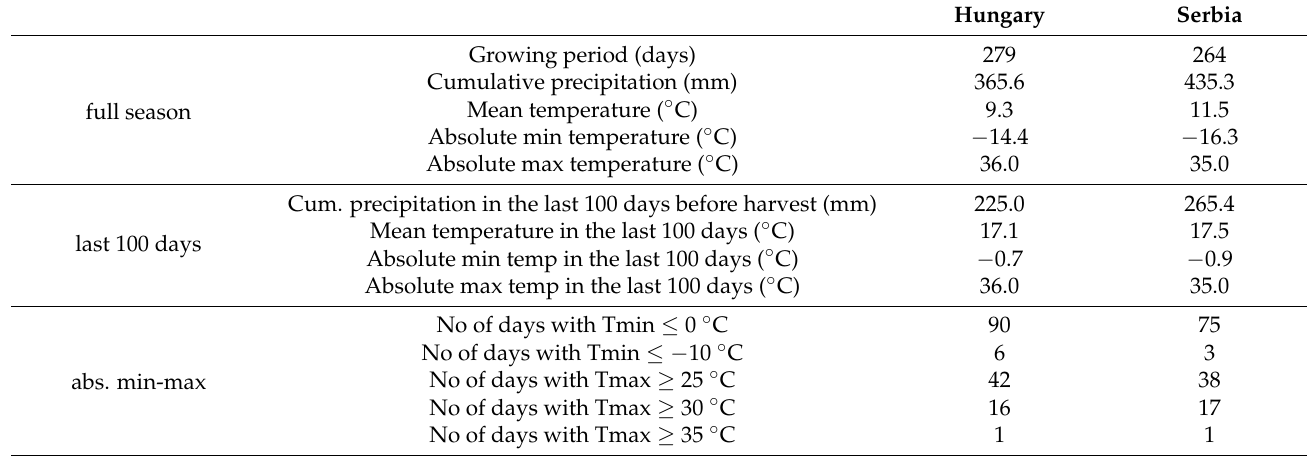
Table 3. Meteorological conditions for the 2018/2019 growing season in Hungary and